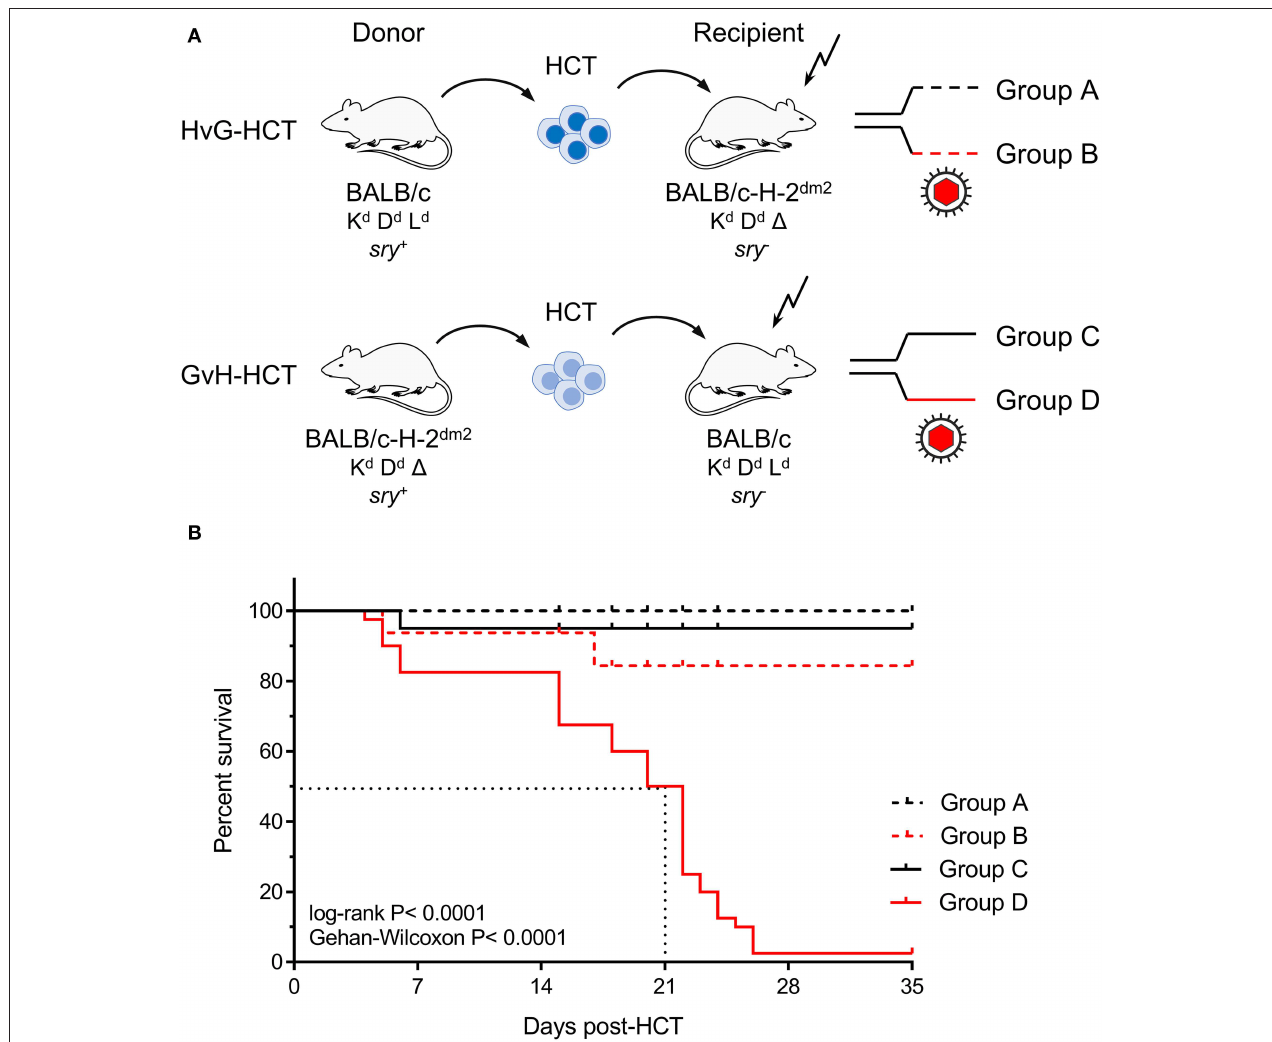
FIGURE 1 | Lethality of infection after GvH-HCT. (A) Sketch of the transplantation models used throughout this study and defining groups A–D. The flash symbol indicates hematoablative conditioning of the HCT recipients by total-body γ -irradiation. (B) Kaplan-Meyer survival plots. The dotted lines indicate the median survival time of mCMV-infected GvH-HCT recipients. Censured animals are